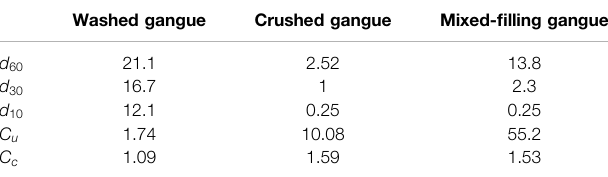
TABLE 4 | Variabe index of gangue gradation. Washed gangue Crushed gangue